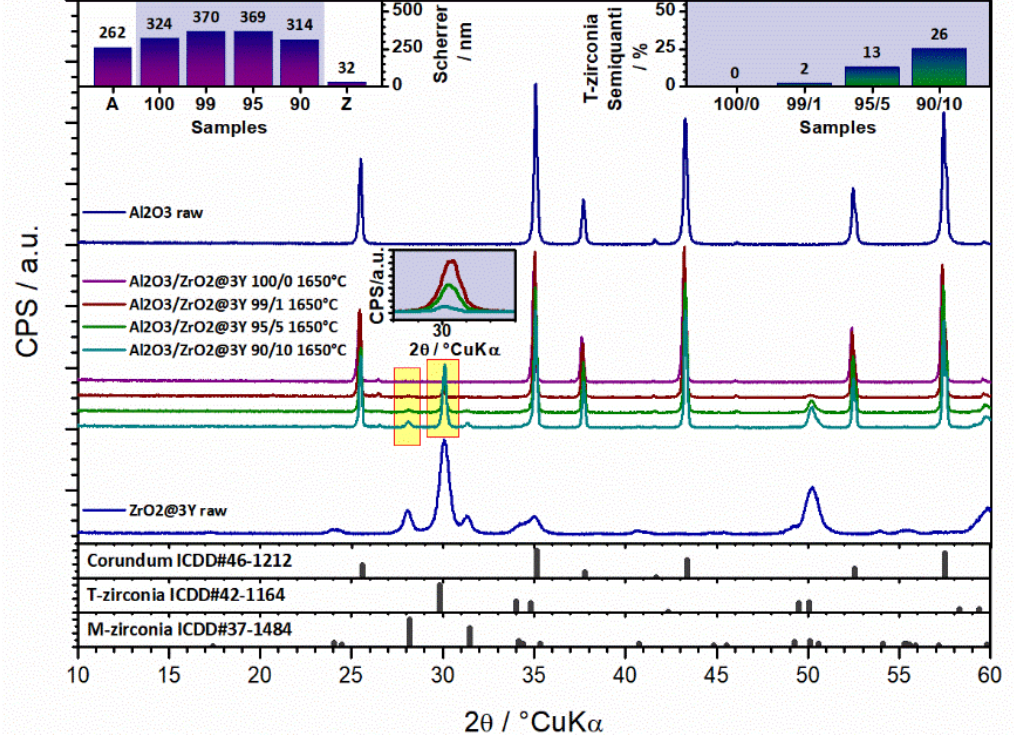
Figure 5. XRD patterns of raw Al 2 O 3 , ZrO 2 and thermal treated (1650 °C) Al 2 O 3 -ZrO 2 composite powders.